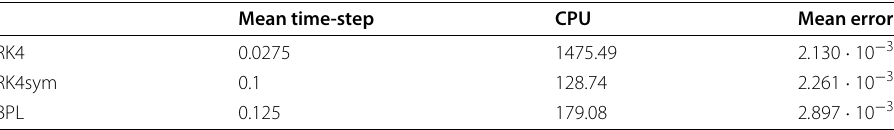
Table 2 Toda lattice Mean time-step CPU Mean error